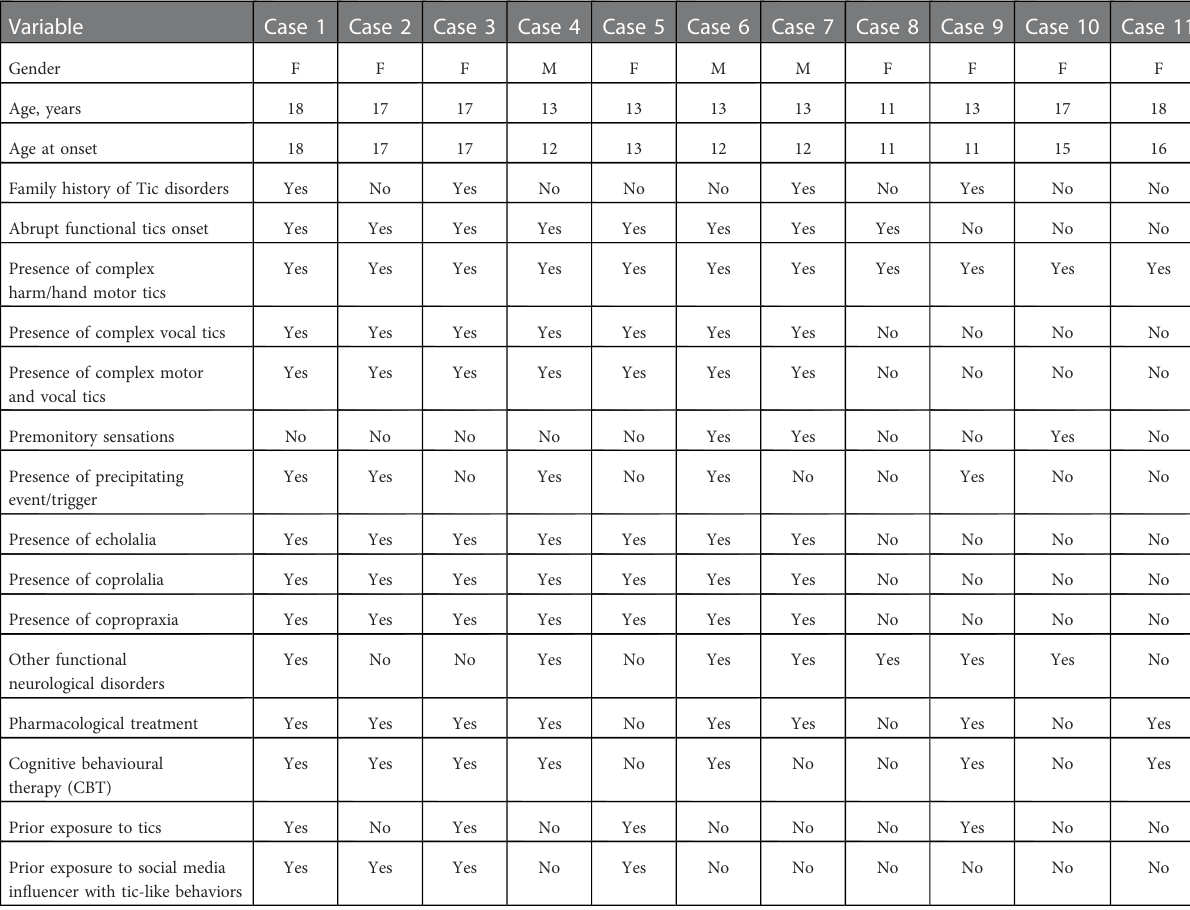
TABLE 1 Clinical features of patients with functional tic-like behaviours (FTLBs). Variable